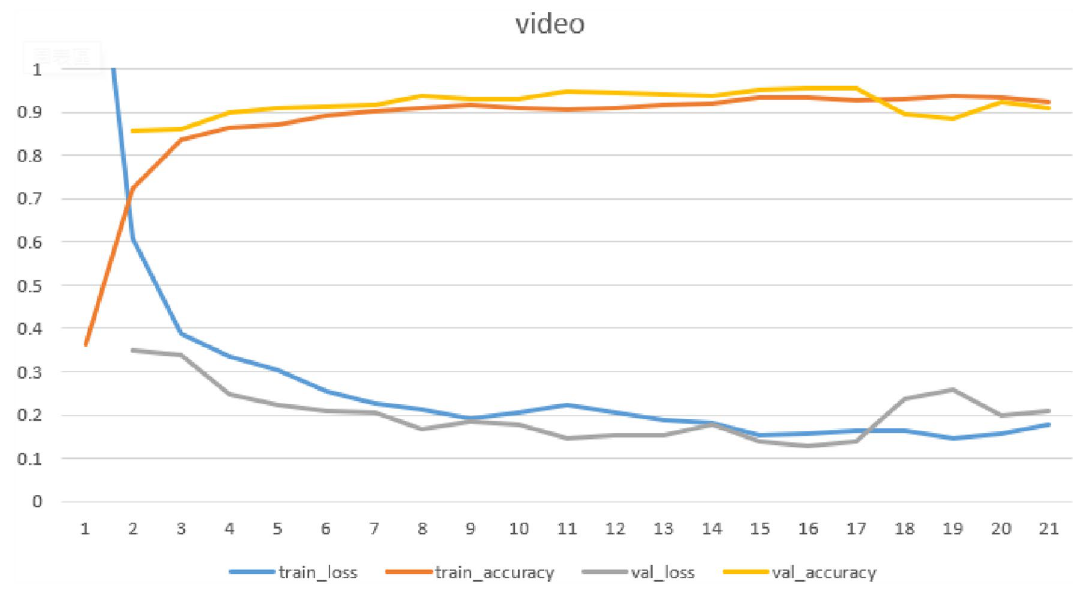
Figure 6. Convergence curve of Inception ResNet-v2.